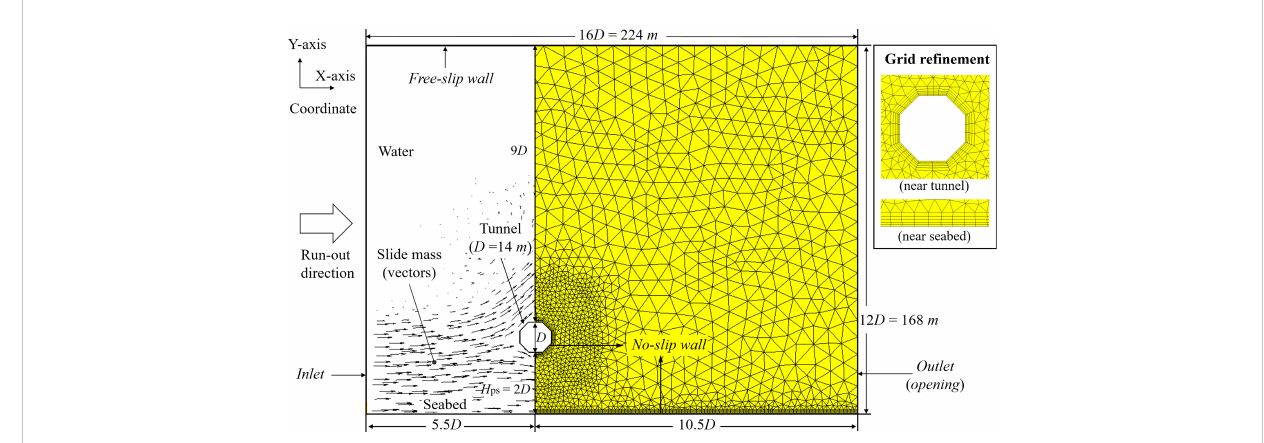
FIGURE 3 CFD numerical modelling on the interaction between the submarine slides and tunnels (an example of the octagon